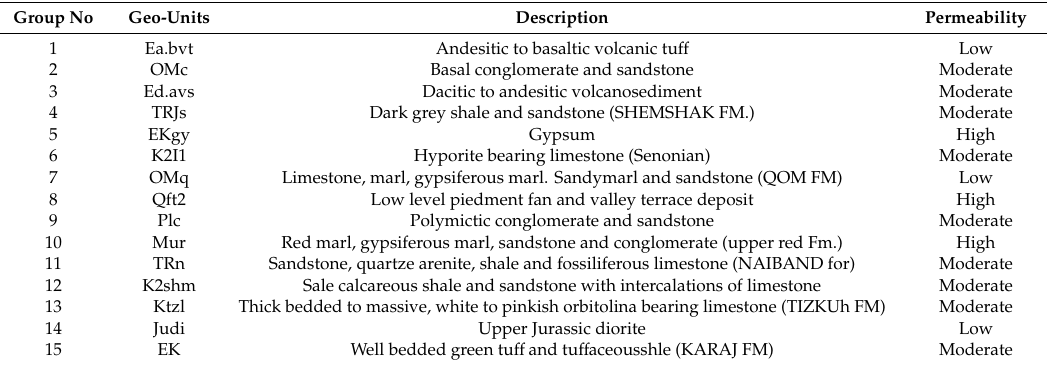
Table 2. Lithology units in the Tafresh watershed and their relative